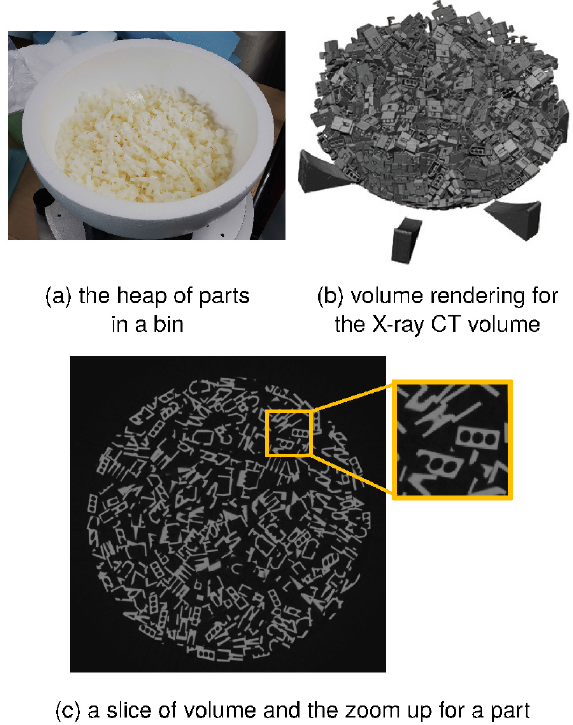
Fig. 1 Our paper discusses bin-scanning , which refers to the process of scanning an X-ray CT volume of randomly stored identical parts in a bin, as shown in (a). The CT volume of binned parts in (a) is visualized by volume rendering in (b), and its slice is shown in